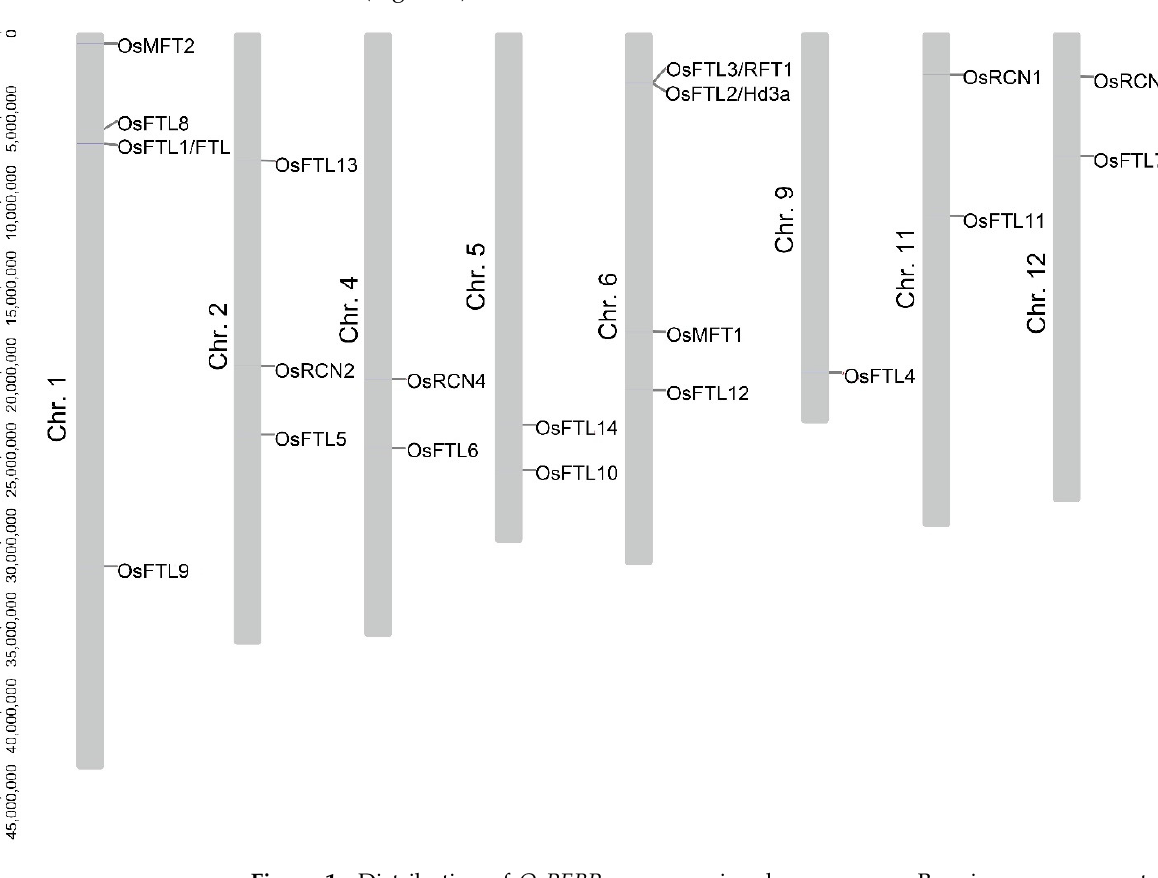
Figure 1. Distribution of OsPEBP genes on rice chromosomes. Bars in gray represent the rice chromosomes. The number on the left of the gray bars are the chromosome number. OsPEBP genes are labeled on the right of each chromosome. The ruler on the left is the scale bar measuring the length of chromosomes.